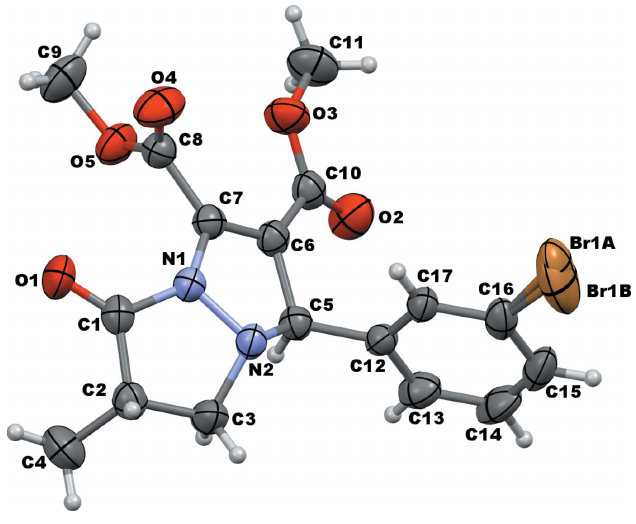
Figure 1 The molecular structure of the title compound showing displacement ellipsoids drawn at the 50% probability